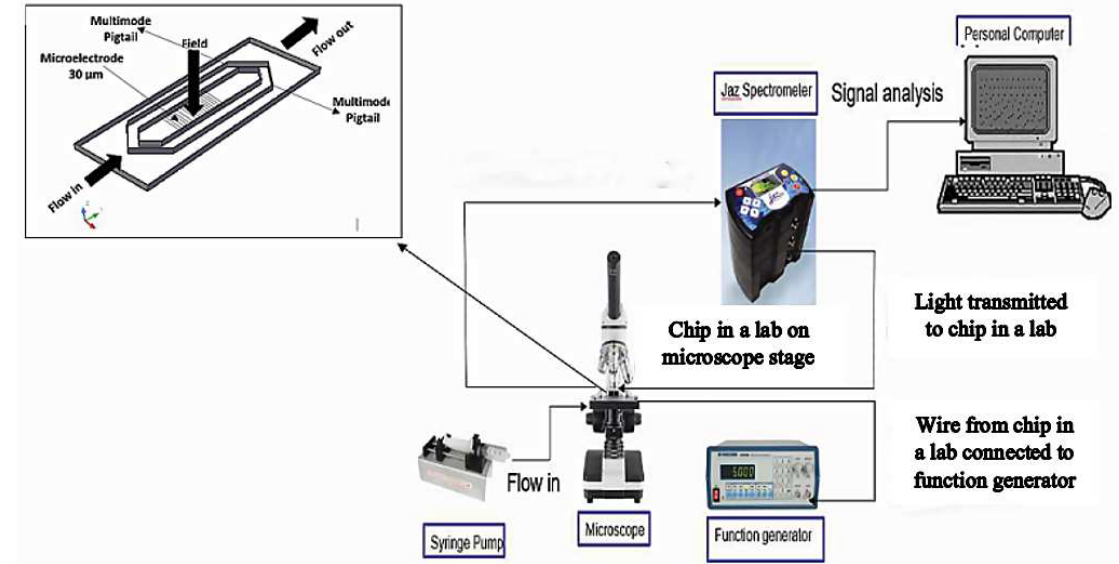
Figure 4. Experimental setup for integrated lab on